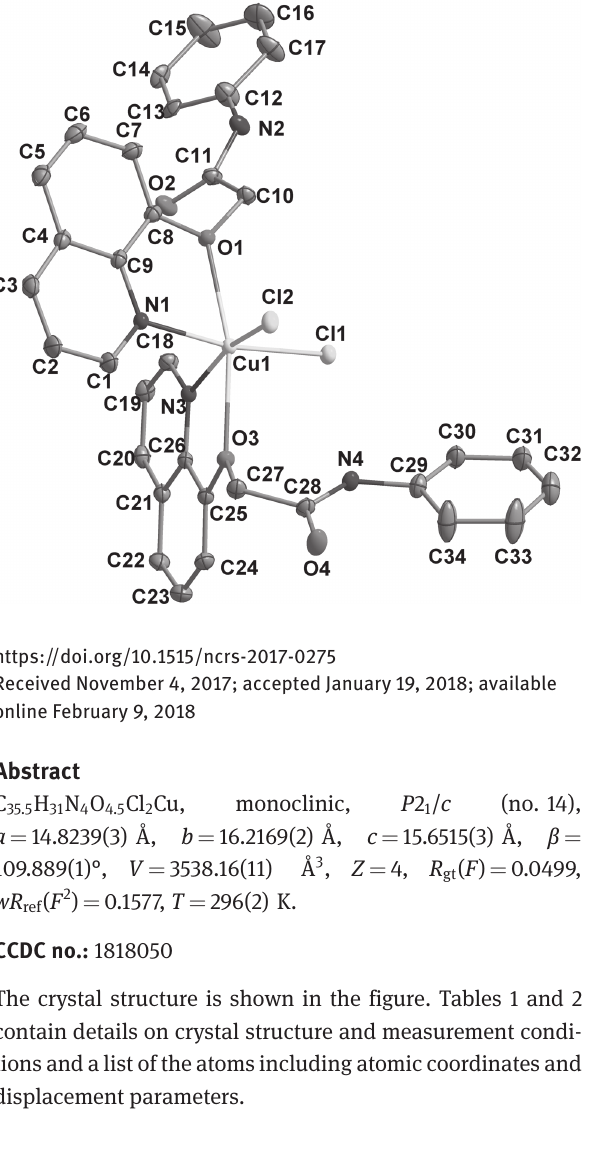
Table 1: Data collection and handling.